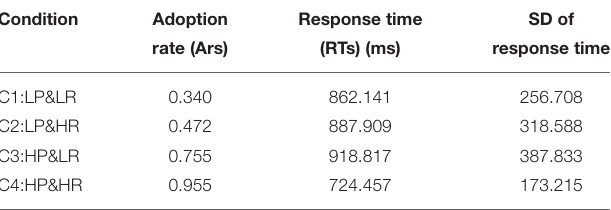
TABLE 1 | Mean adoption rate and mean response time across four